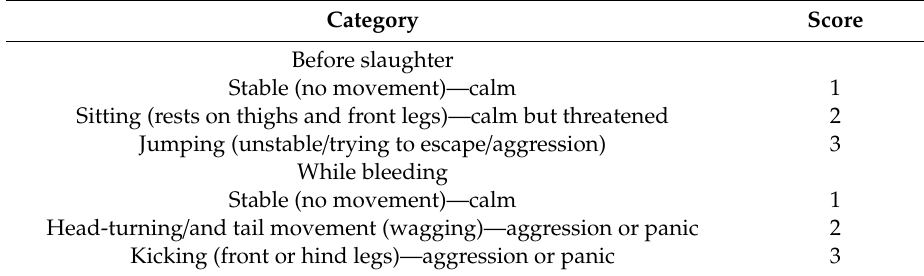
Table 1. Stress-related behavioural scores for goats slaughtered using transverse neck incision (TNI), suprasternal notch targeting the heart (SNP), and piercing with a short spear under-shoulder-blade chest-floor point-of-elbow (CFP) methods. Category Score Before slaughter Stable (no movement)—calm 1 Sitting (rests on thighs and front legs)—calm but threatened 2 Jumping (unstable / trying to escape / aggression) 3 While bleeding Stable (no movement)—calm 1 Head-turning / and tail movement (wagging)—aggression or panic 2 Kicking (front or hind legs)—aggression or panic